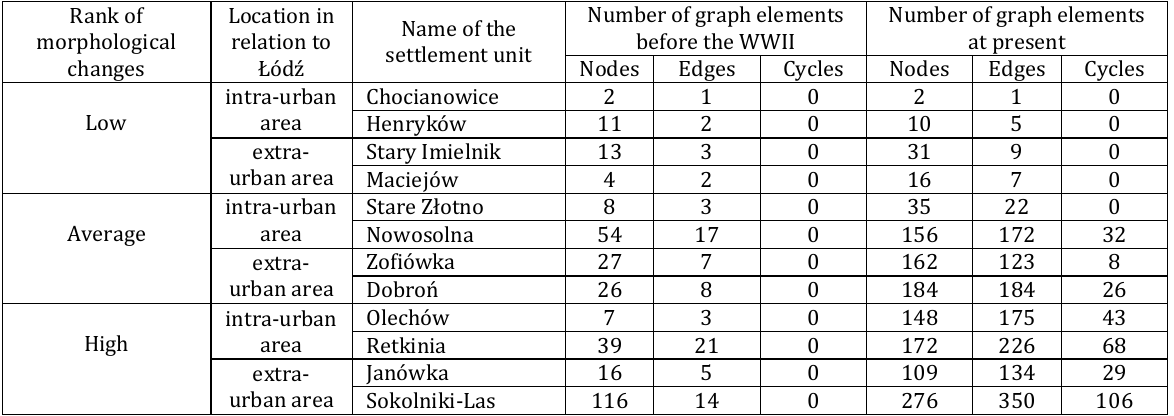
Table 1. Change in the number of nodes, edges and graph cycles in the studied units in the inter-war and contemporary period (Source: own